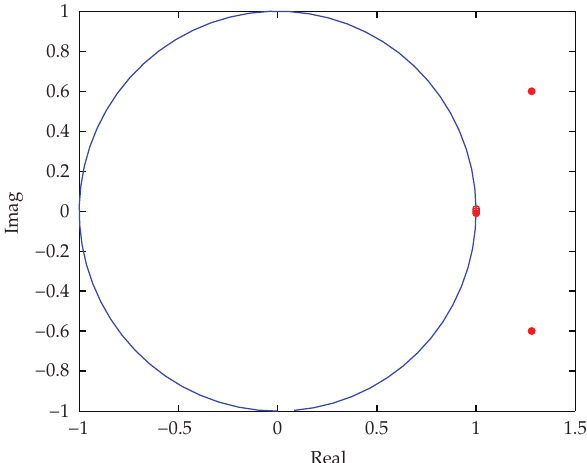
Figure 6: The eigenvalues of the unstable limit cycle displayed on the unit